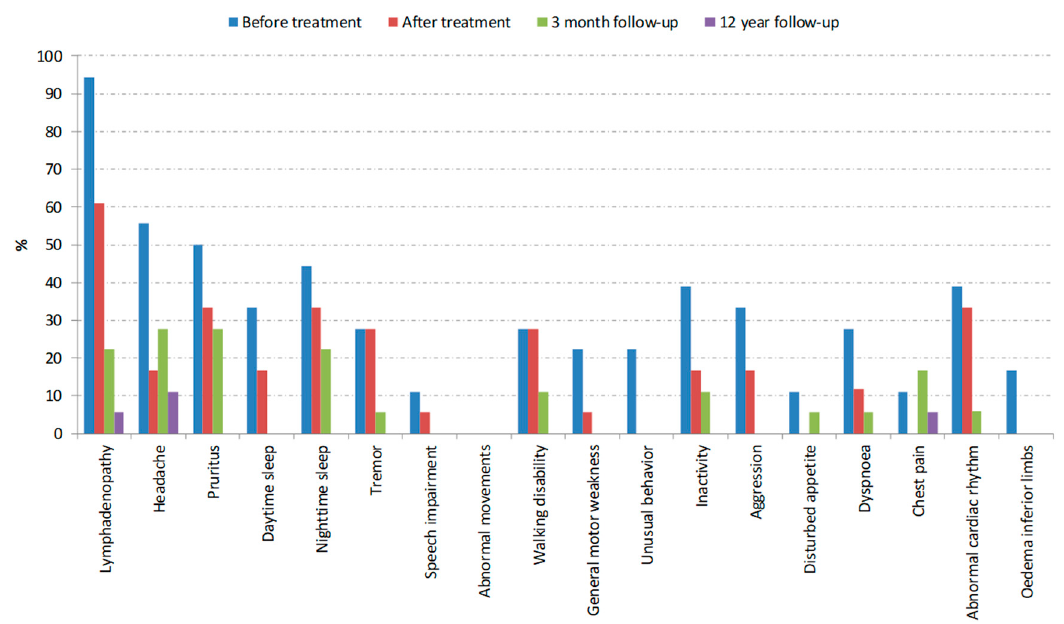
Figure 3. Second stage HAT patients: Prevalence of signs and symptoms at different time points. Absence of a bar indicates 0% prevalence at a certain time point. Table 1. Descriptive characteristics for first and second stage HAT patients and their controls.